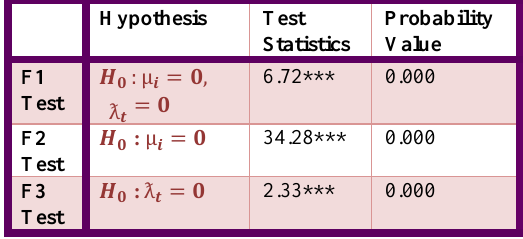
Table 7: F Tests for Companies Traded in Other Countries’ Stock Exchanges Hypothesis Test